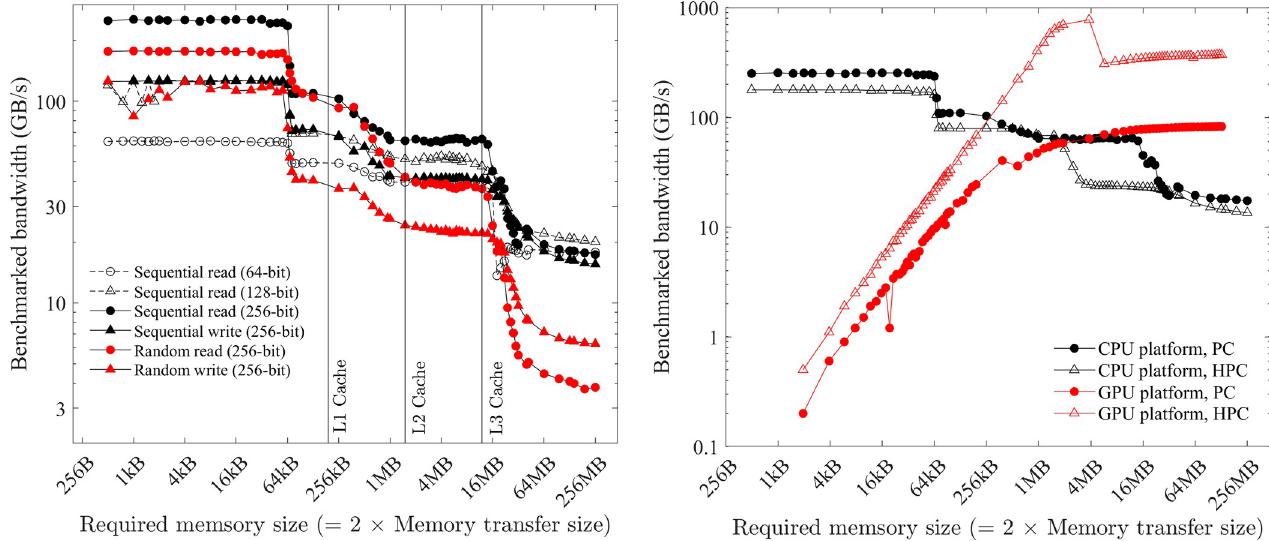
Fig 5. Benchmarked bandwidth. (a) from bandwidth-benchmark on the PC. (b) CPU platform from bandwidth-benchmark for sequential 256-bit read and GPU platform from bandwidthTest of CUDA samples with “shmoo” mode.